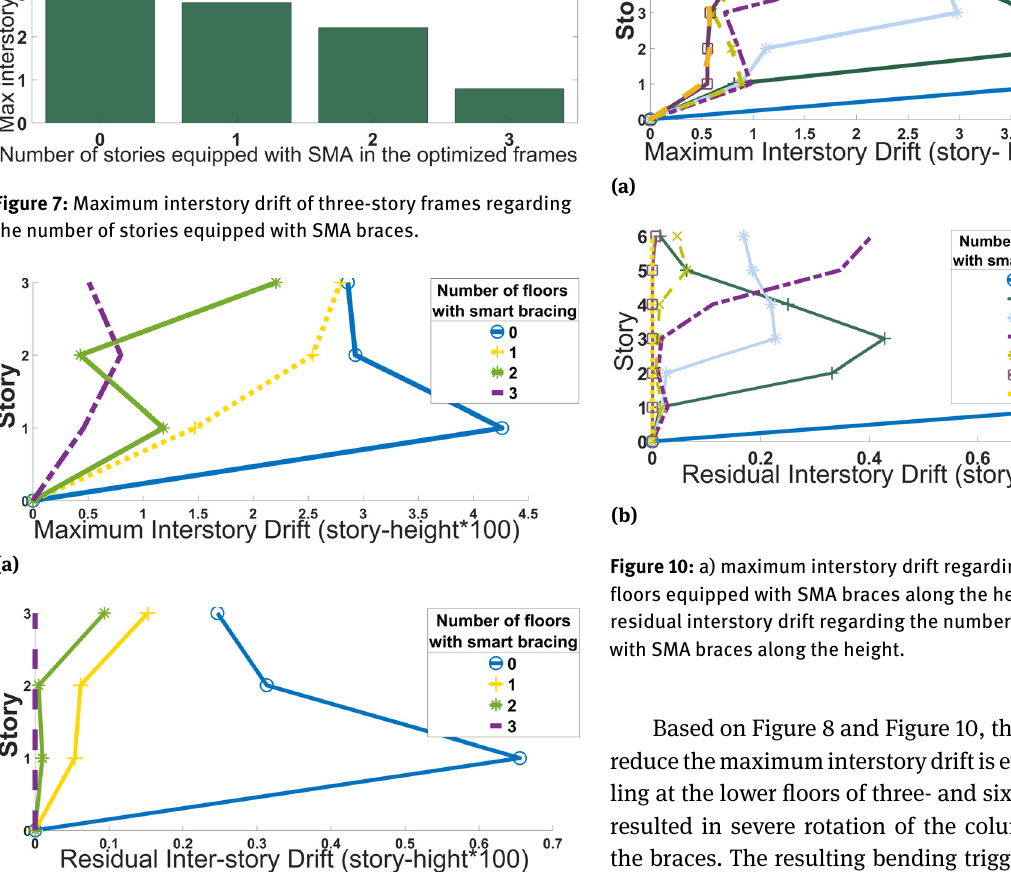
ure 10, was smaller for the dual-braced frames that had more stories equipped with SMA.